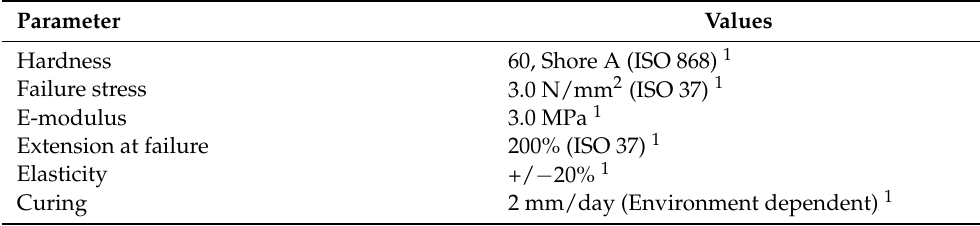
Figure 9. Cut grooves used for the strengthening system mounting. Photograph by S&P. Table 2. Properties of the flexible